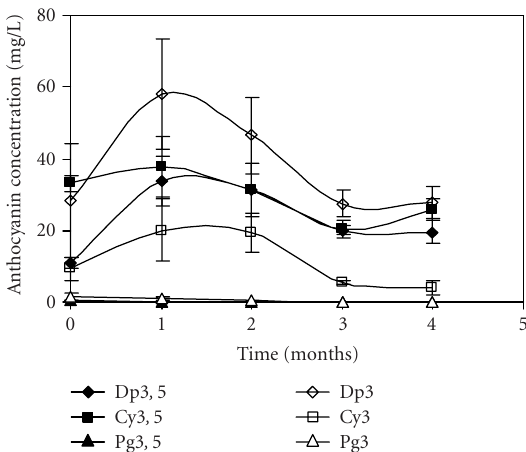
Figure 5. Evolution of delphinidin 3,5-diglucoside (Dp3,5), cyanidin 3,5-diglucoside (Cy3,5), pelargonidin 3,5-diglucoside (Pg3,5), delphinidin 3-glucoside (Dp3), cyanidin 3-glucoside (Cy3), and pelargonidin 3-glucoside (Pg3) concentration in “As- saria” pomegranate juice from fruits covered with polyethylene film, during storage at 5 ◦ C. The concentrations of anthocyanins were calculated from standard curves of Dp3,5; Dp3; Cy3,5; Cy3, Pg3,5, and Pg3. Bars represent standard deviations of four replicates.